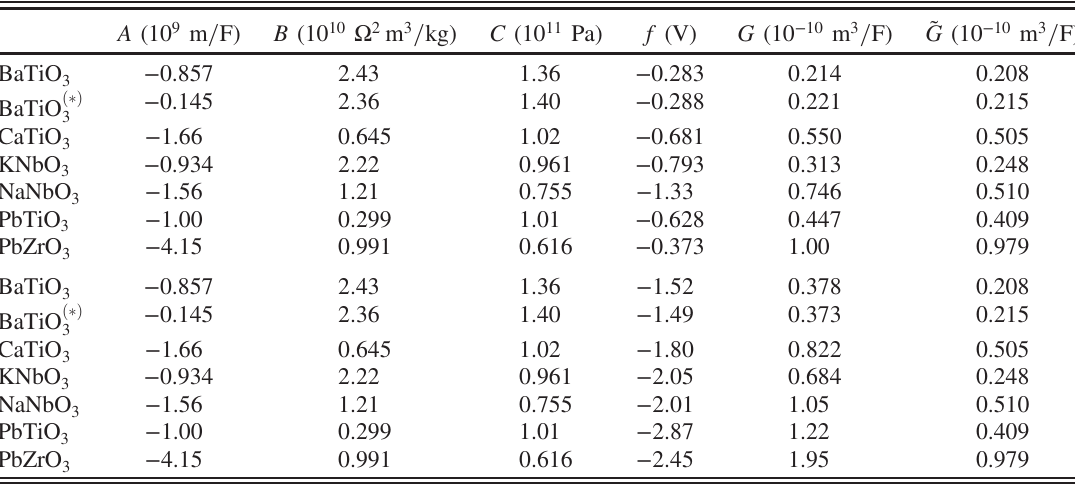
TABLE V. Coefficients (in SI units) of the Landau model of Eq. (1) computed from DFT calculations, when P 0 is the spontaneous polarization of the bulk crystal (measured in C = m 2 ). In the top block unit weights are used. In the bottom block physical atomic masses are